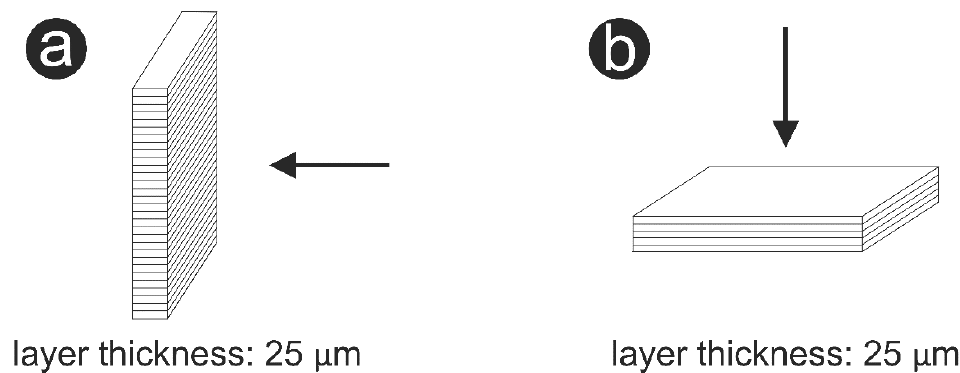
Figure 1. Schematic showing the building direction of the additively manufactured specimens. ( a ): 90°; ( b ): 0°. Arrows indicate the load direction during the biaxial flexural strength test.